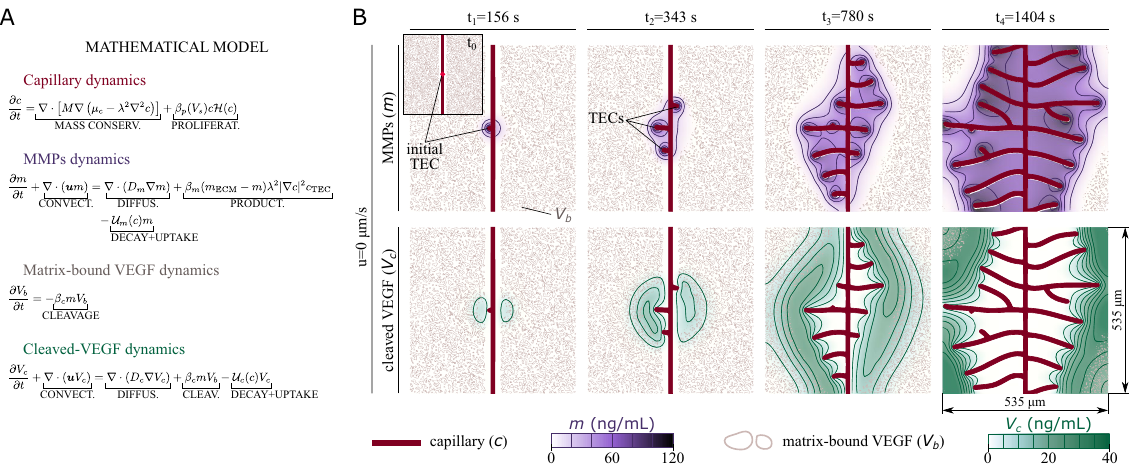
Figure 4. Computational modeling and simulation of flow-mediated angiogenesis driven by matrix-bound chemokines. (A) Model equations. Tip cells are modeled as discrete agents and follow the set of rules described in Supplementary Information, Discrete compartment . (B) Problem configuration used in the paper. The results correspond to capillary growth controlled by matrix-bound VEGF in the absence of interstitial flow. The top- left inset shows the initial configuration, which includes the matrix-bound VEGF clusters, a parent vessel, and a non-motile TEC secreting MMPs. The initial TEC begins motion once it fulfills all the conditions for TEC activation. The main panels show the MMPs (top row) and cleaved-VEGF (bottom row) distributions at four different times. Both rows display the capillary network (red) and the contour lines of the matrix-bound VEGF clusters